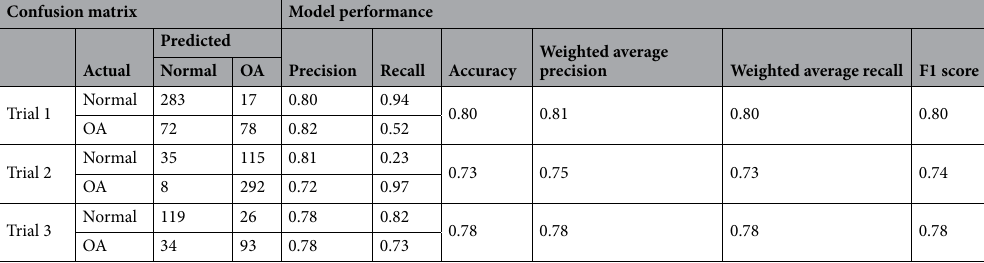
Table 3. Confusion matrix and model performance in each Trial. OA, temporomandibular joint